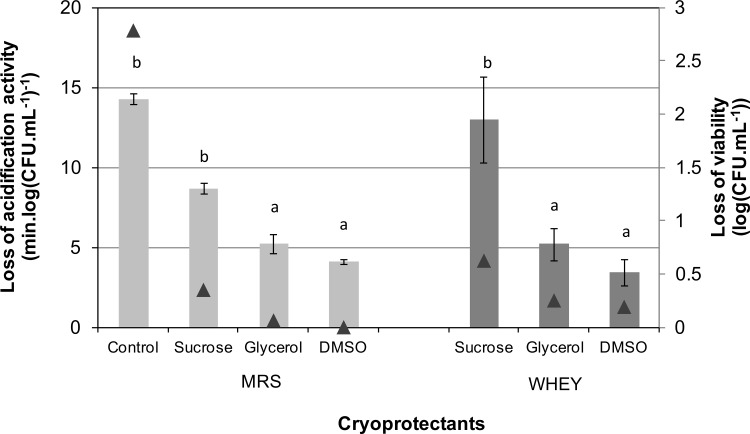
The effects of cryoprotective agents on the loss of specific acidification activity and viability upon freeze-thawing of L. bulgaricus CFL1.Cells were grown in either whey or MRS medium, harvested in stationary culture phase and frozen to -80°C at 2°C min-1 with sucrose, glycerol or DMSO (all additives at 0.58 M) and no additive (control: 1 g.L-1 peptone water). Superscripts letters represent statistical contrasts (significant differences) between samples at the 95% confidence level. Control whey grown cells displayed an extreme loss in cell function (64.8 ± 3.5 (min.log(CFU.mL-1)-1)) and viability upon thawing (3.3 ± 0.3 log(CFU.mL-1)), and for clarity are not included in this figure.